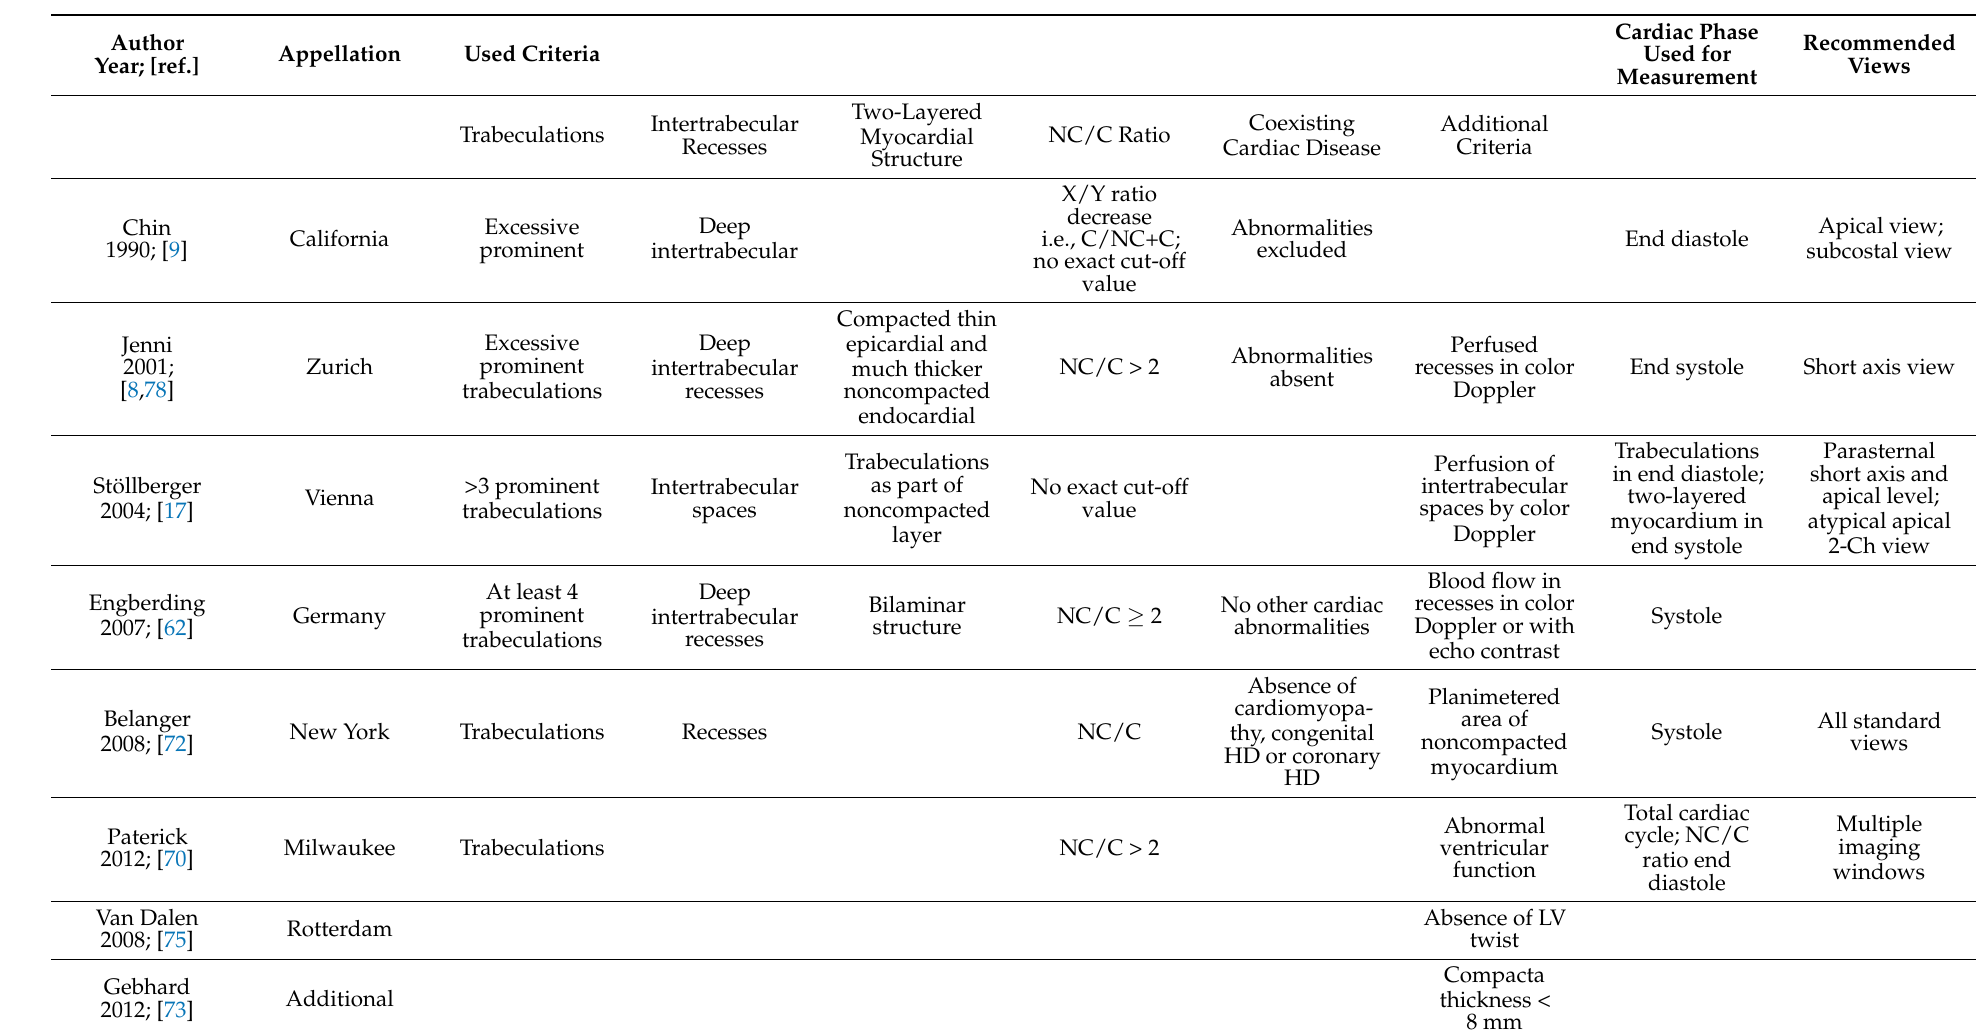
Table 5. Different echocardiographic criteria for the diagnosis of